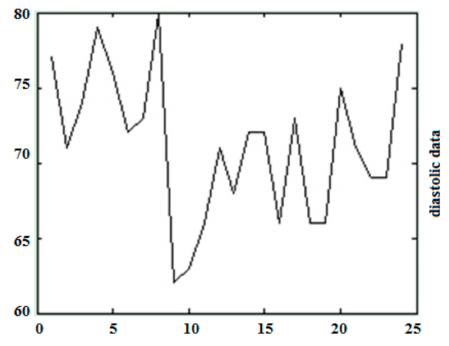
Figure 21. The input data for diastolic.